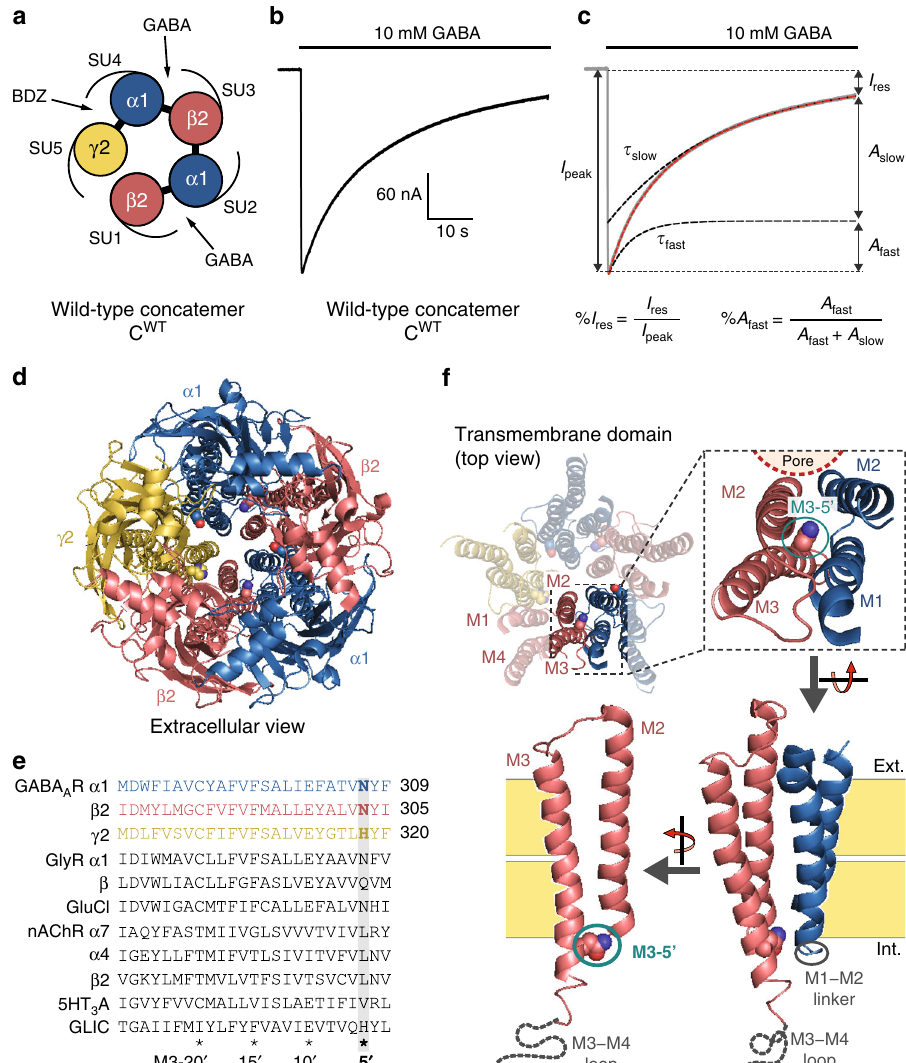
3.3 s, respectively, as compared to 18 s for C WT . The three mutations accelerate fast desensitization by about 2-fold and